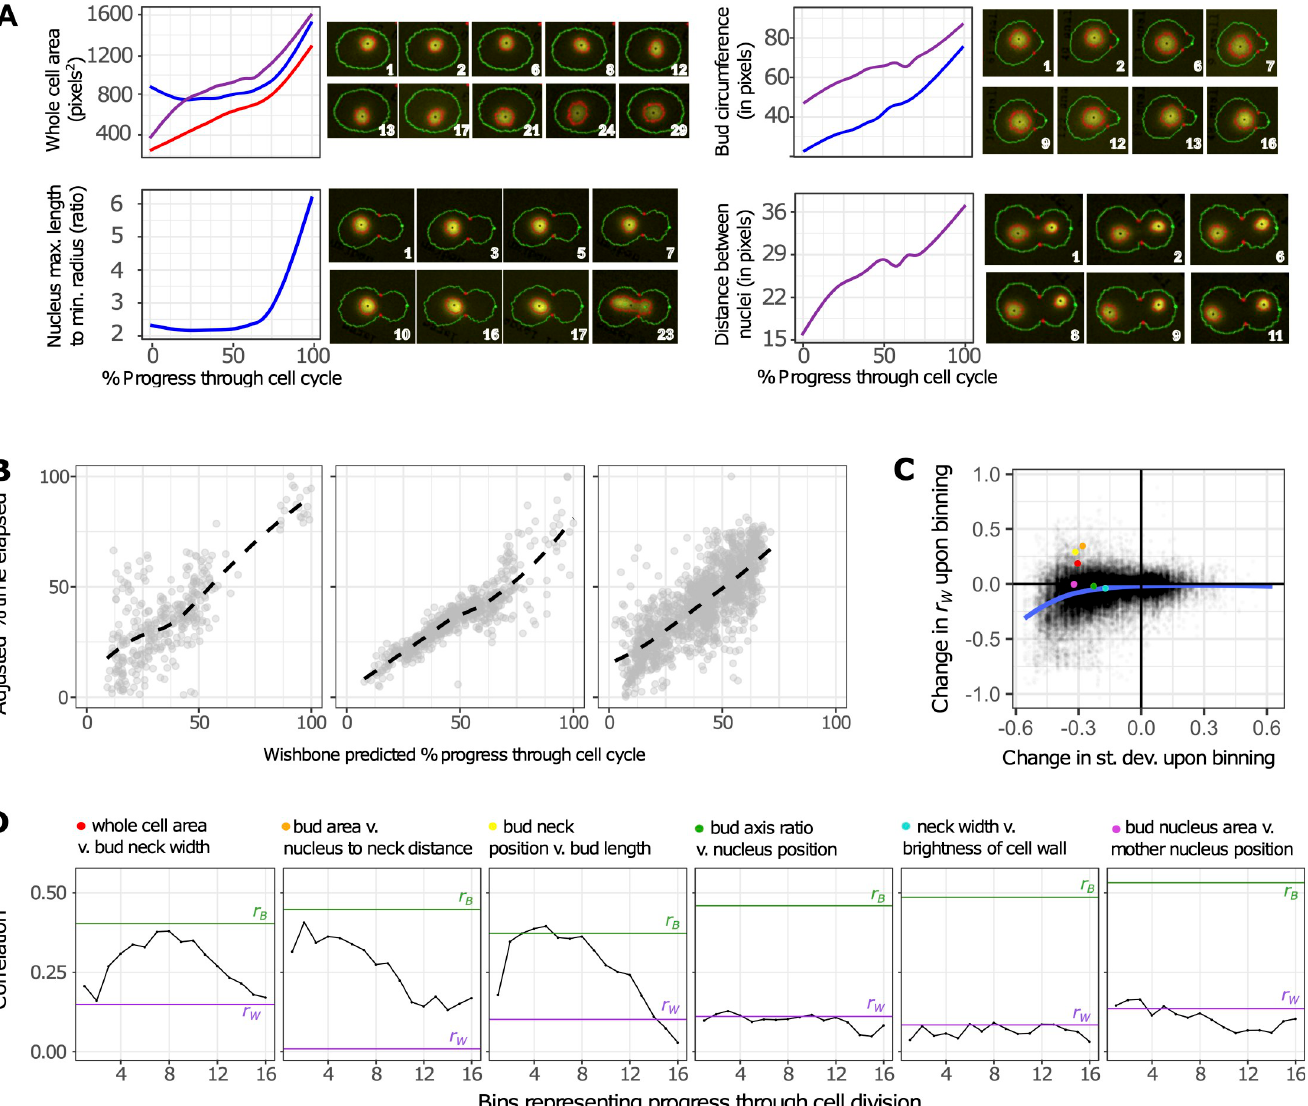
Fig 4. Morphological features vary as cells divide. The morphological features of unbudded (red), small-budded (blue), and large-budded (purple) cells change as these cells progress through the cell cycle. (A) Variation of four traits through the cell cycle. Line plots represent fixed-cell images from all 374 mapping-family strains, positioned on the horizontal axis based on progression through the cell cycle as calculated by Wishbone [74]. Regression lines are smoothed with cubic splines, calculated with the “gam” method in the R package ggplot2 [99], to depict trends describing how each displayed trait varies across the estimated growth trajectory. The displayed trends match those observed in micrographs of live cells progressing through division. Each series of micrographs displays a different live cell imaged over several minutes, which are displayed in the lower right corner of each micrograph. (B) Centered data for 11, 23, and 44 unbudded, small-budded, and large-budded cells, respectively, show how Wishbone sorts live cells in a way that recapitulates the actual time series. Each point in these plots represents a cell image from a single time point. The horizontal axis represents Wishbone’s estimation of how far that cell has progressed through division. The vertical axis displays time as a percentage of the total time elapsed and adjusted in a way that controls for every cell having started at a different place in the cell division cycle at time zero. Trend lines are smooth fits using the “loess” method in the R package ggplot [99]. (C) The correlation between some morphological features changes throughout the course of cell division. The scatterplot shows how binning influences both the phenotypic correlation (vertical axis) and phenotypic variation (horizontal axis) across clones. Each point represents these values for a pair of traits as measured in 1 of 16 bins. The value on the horizontal axis represents whichever trait in each pair had the larger decrease in standard deviation (“st. dev.”), as such decreases are likely to reduce the correlation on the vertical axis. The blue line shows a smooth fit by loess regression. Colored points on the scatterplot correspond to bin 5 for each pair of traits represented by the line plots in (D). (D) These line plots show three pairs of traits for which binning increases r W such that it approaches r B (leftmost three plots), and three pairs of traits for which r W does not approach r B even after binning (rightmost three plots). In each plot, r B is shown as the horizontal green line, r W (without binning) is shown as the horizontal purple line, and r W for each bin is shown in black. Data underlying this figure can be found at https://osf.io/b7ny5/. max., maximum; min., minimum.